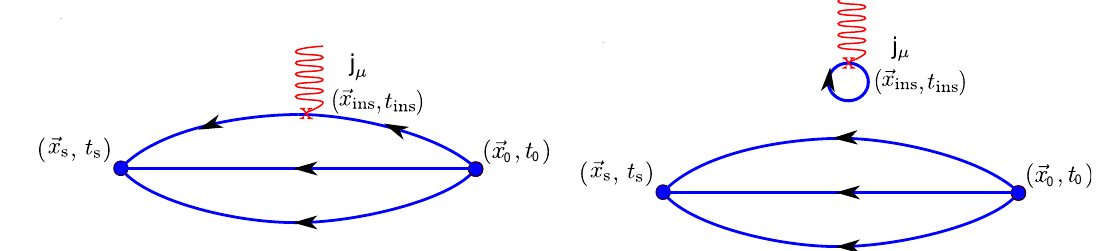
Figure 4: Left: Masses of spin 1 / 2 baryons. The mass of Ξ by lattice QCD and confirmed by LHCb [ 8 ] . It is higher than the value by SELEX [ 9 ] , shown by the grey band. Right: Masses of spin-3 / 2 baryons [ 10 ] . The mass of Λ used to fix the charm quark mass.